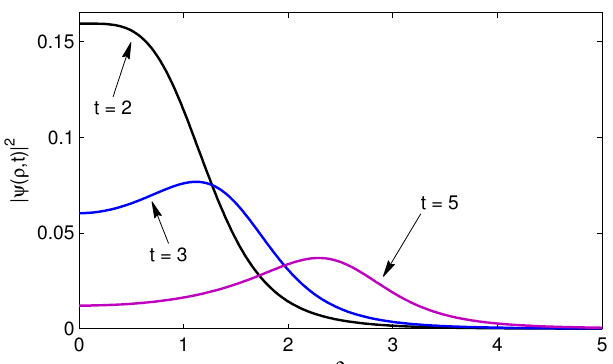
Figure 5. Time evolution of the rotationally symmetric Cauchy initial wave packet Equation (51) for the parameter ε =